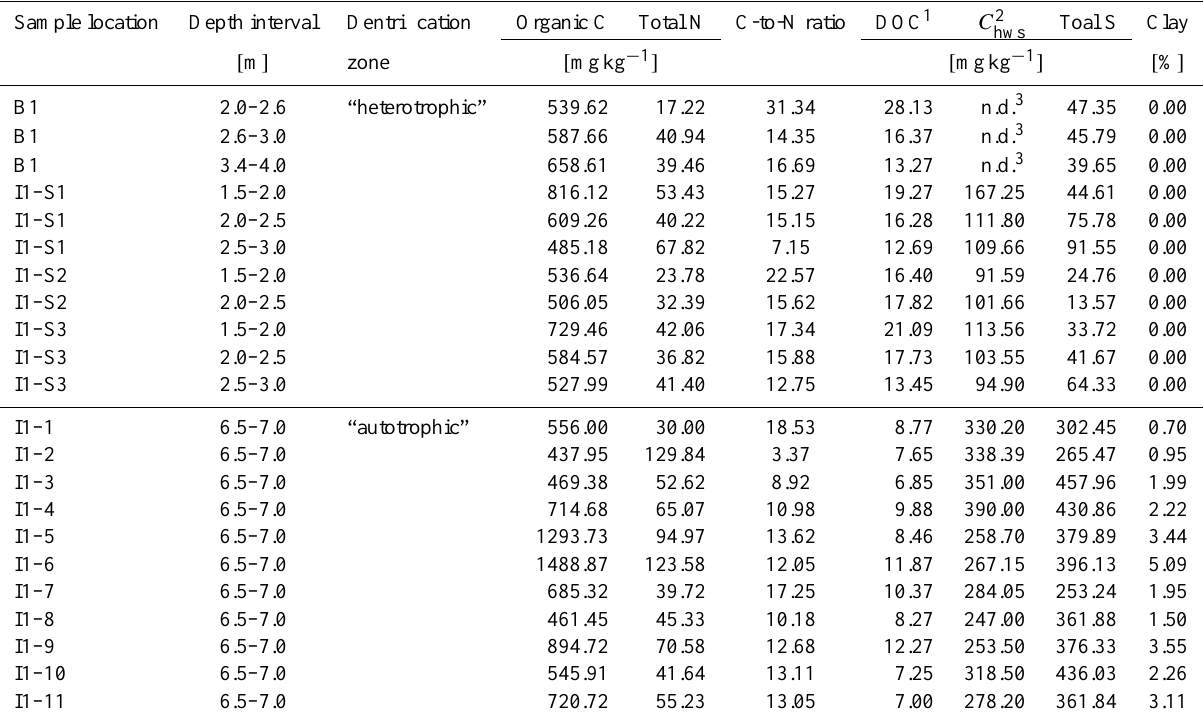
Table 1. Location and basic properties of the investigated aquifer